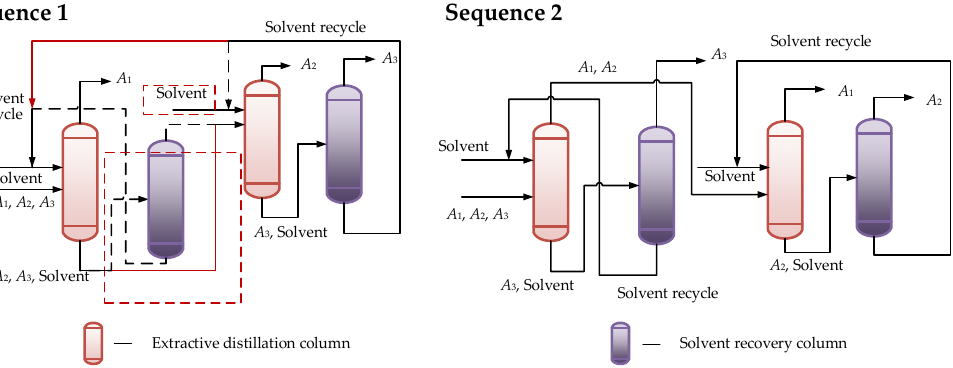
Figure 1. Distillation sequences of separating three-component mixture.